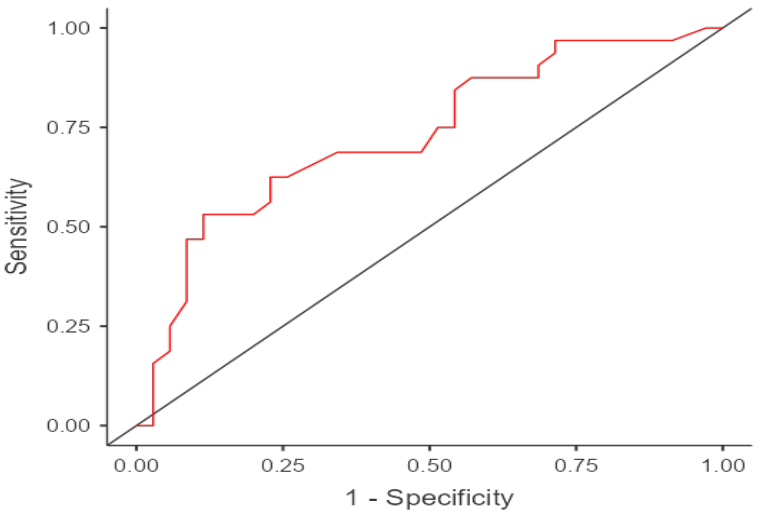
Figure 2. Curve ROC The area under the curve (AUC) was 0.731 (95% CI: 0.402–0.657; p = 0.003). The sensitivity and specificity obtained was 62% and 77%, respectively.